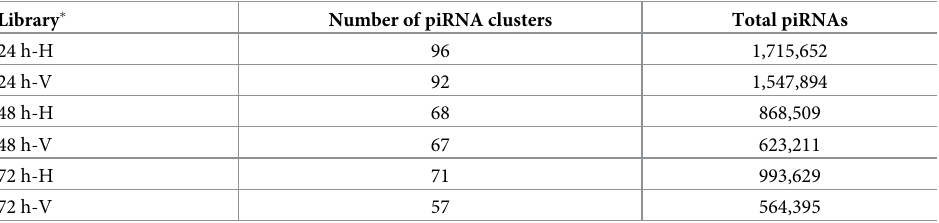
Table 2. Summary of identified piRNA clusters in different libraries.